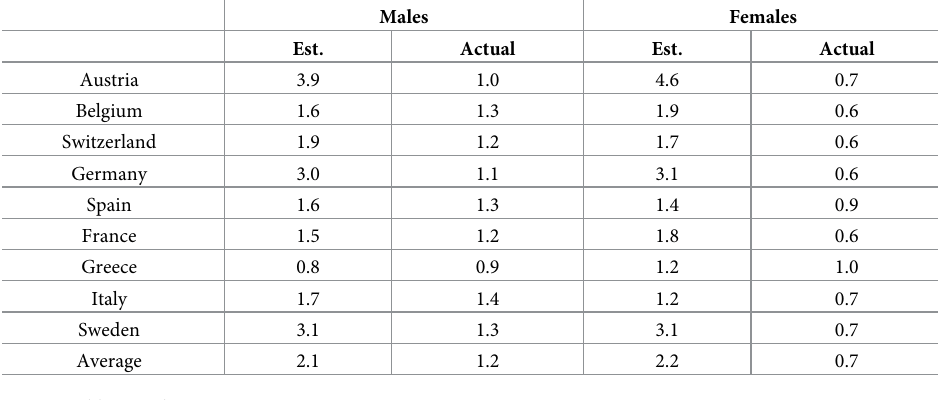
Table 5. Temporal change in subjective and actual life expectancy from 2004 to 2015 (values in 2015 minus values in 2004), males and females. Males Females Est. Actual